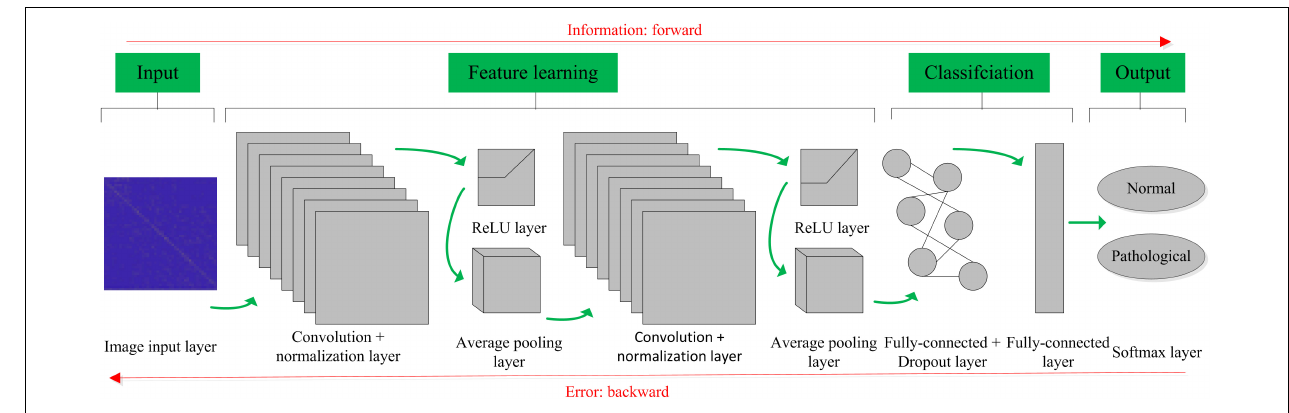
FIGURE 4 | Convolutional neural network (CNN) architecture designed for the proposed computer-aided diagnosis (CAD) system in this